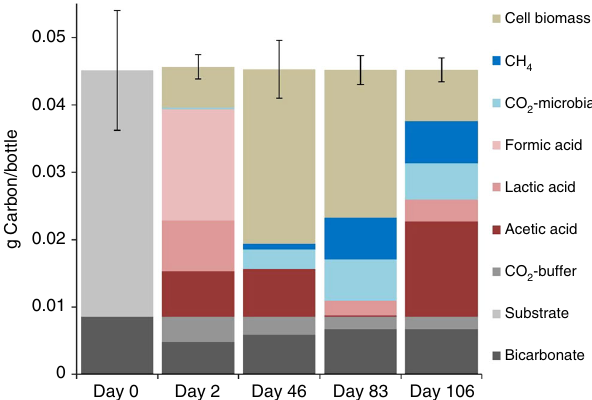
Fig. 7 Carbon balance of fi ve-carbon microcosms at sampling intervals. The sampling intervals are day 2, 46, 83 and 128. The columns represent the cumulative carbon levels of various compounds. Day 0 represents the total carbon (g per bottle) initially added to the system. Data points represent the means ± s.d., n = 3 per group